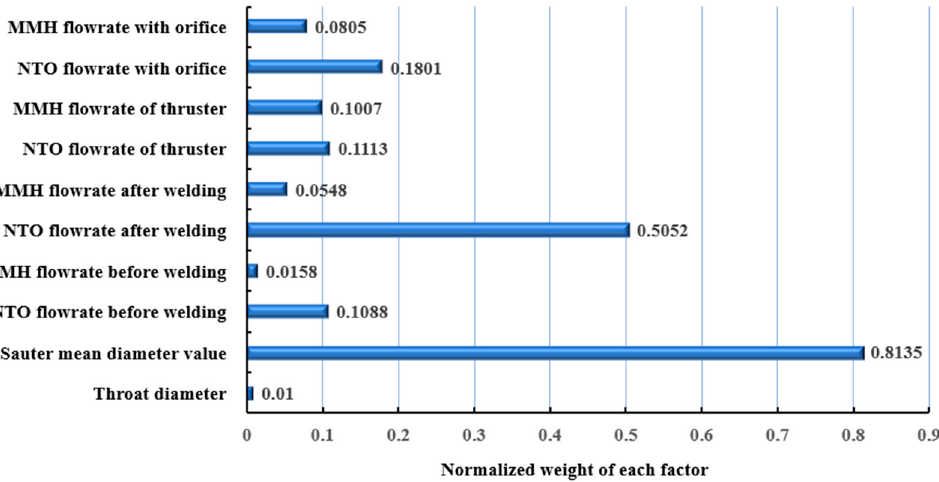
Figure 4. A comparison of the influence of the normalized weight of each factor.